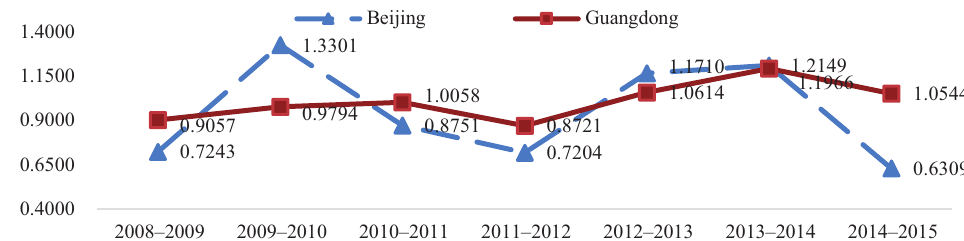
Figure 10. The line graph of the average common-weight global MPI of Beijing and Guangdong